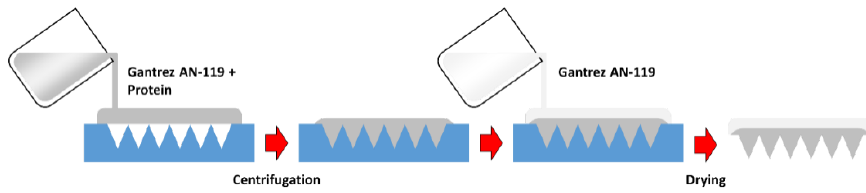
Figure 1. Diagram showing microneedle preparation. Formulation containing rLTB protein was poured into each silicon micromold. The polymer used for this work was Gantrez ®